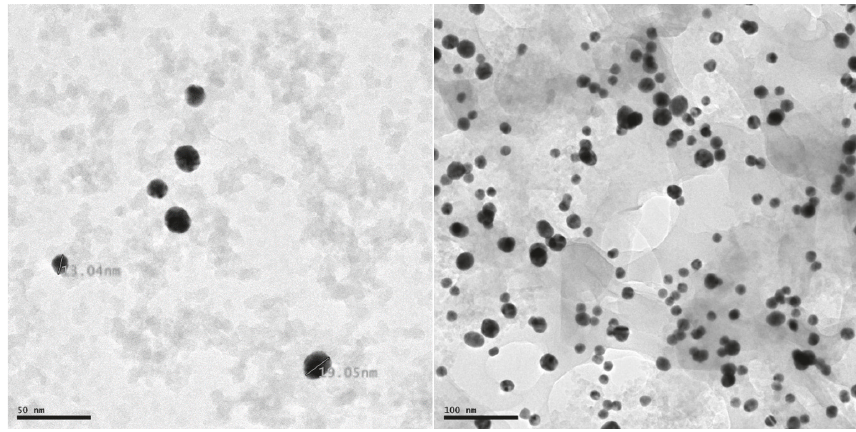
Figure 1: Transmission electron microscopy images of nanogold particles in citrate buffer 1